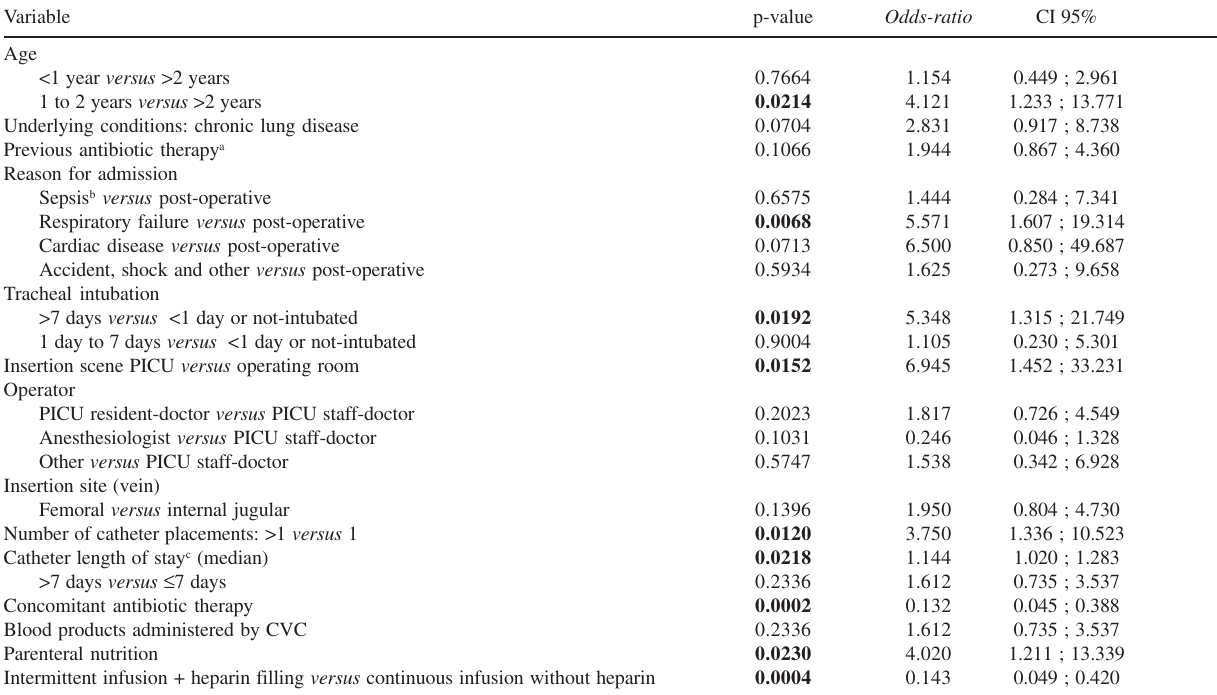
Table 2 - Analysis of risk factors for catheter-related infection by univariate logistic regression analysis. Variable